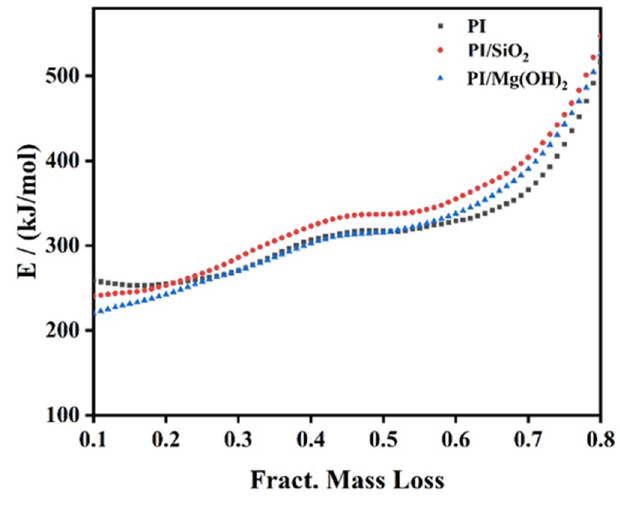
Figure 6. Results of the Friedman calculation.